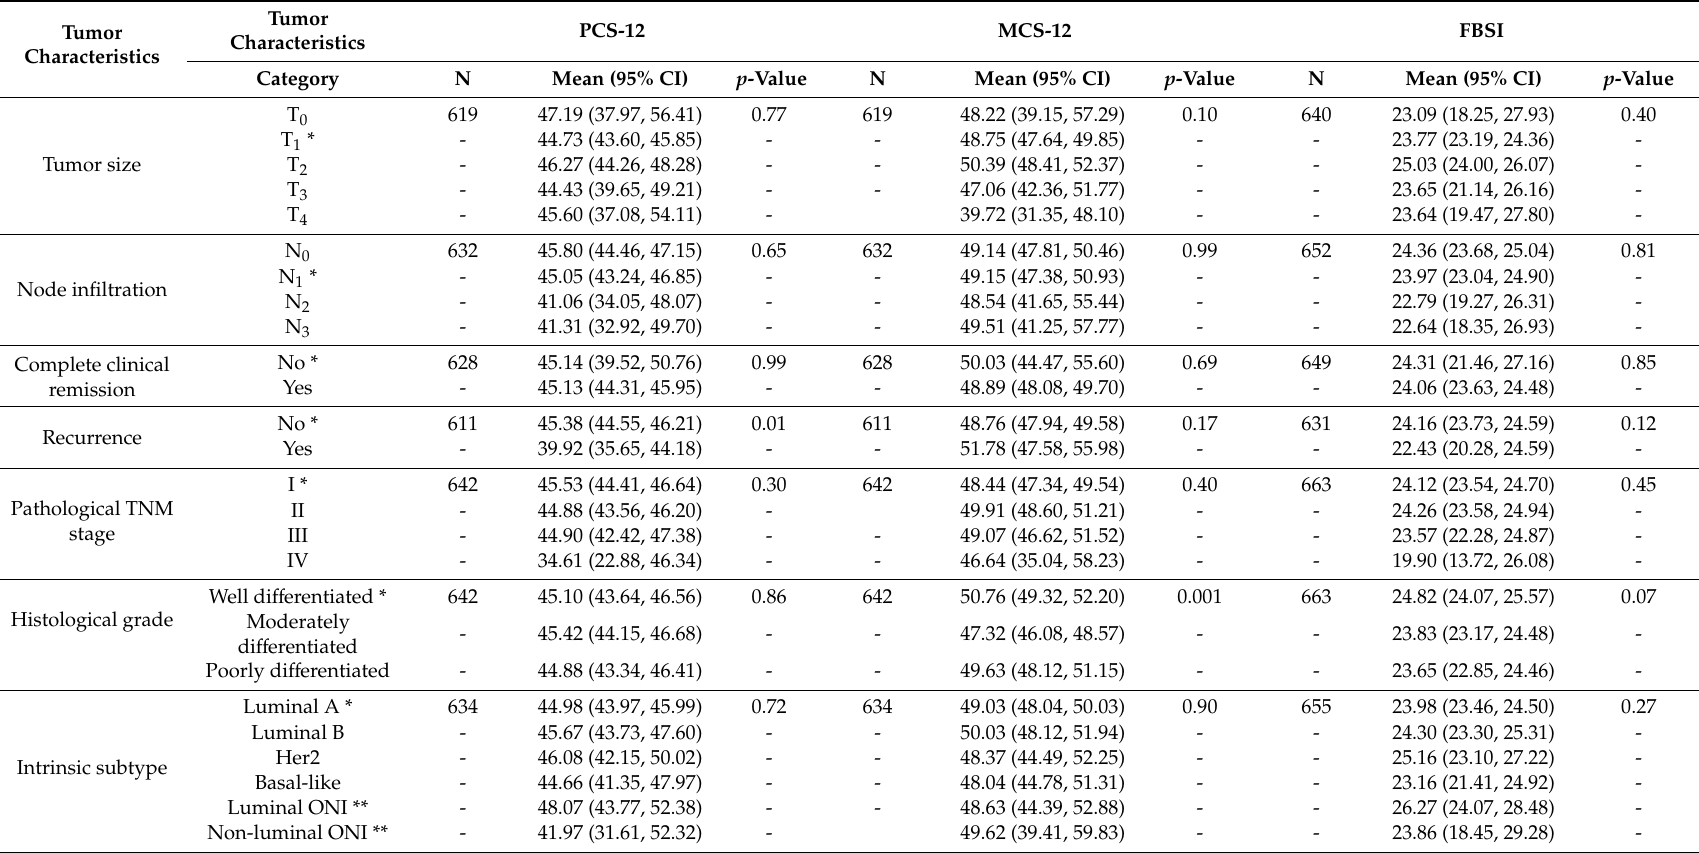
Table 2. Marginal means of health-related quality of life scores according to the tumor